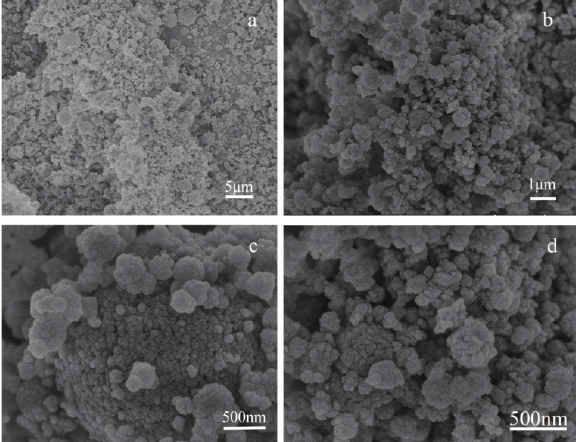
nano-powder. Where the sample was Figure 3: SEM images of CaF 2 produced on the basis of the reaction time 70 min, the temperature 40°C, the Ca/F molar ratio 0.4.